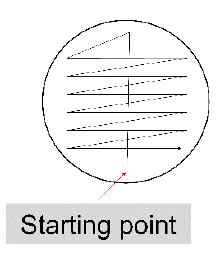
Figure 1. Urine culture using the calibrated loop/surface streak method.